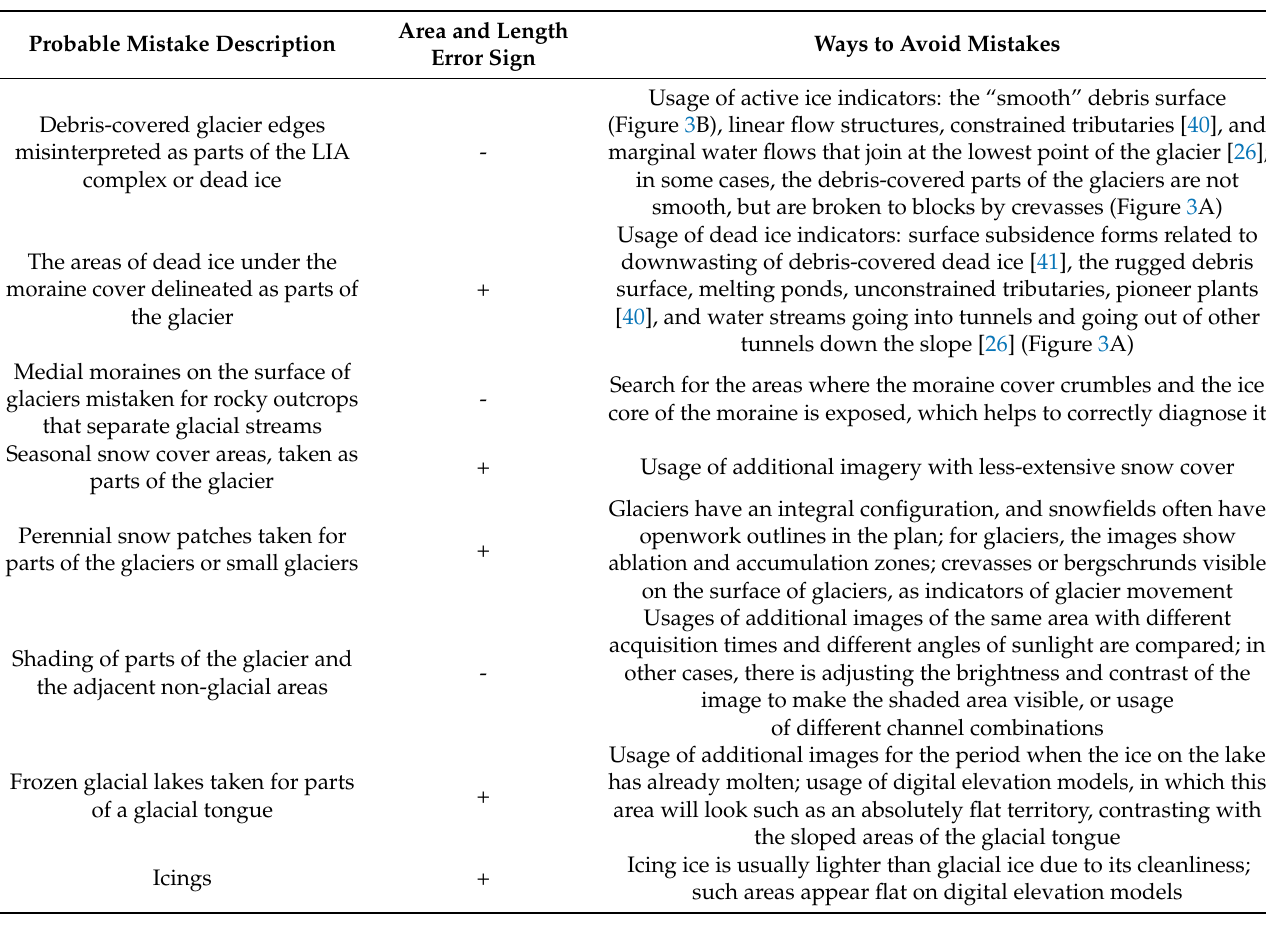
Table 2. Main mistakes in glacier delineation and the ways to avoid